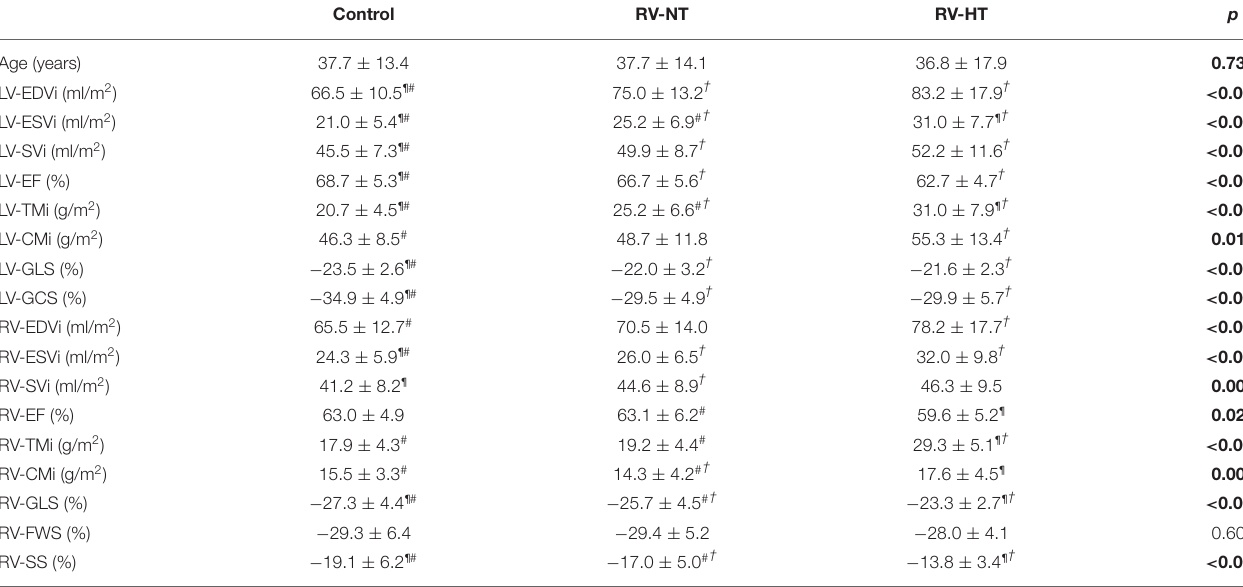
TABLE 2 | Comparison of the left and right ventricular volumetric and functional (A) and strain (B) parameters of LVNC patients with right ventricular hypertrabeculation, patients with normal right ventricular trabeculation, and controls.